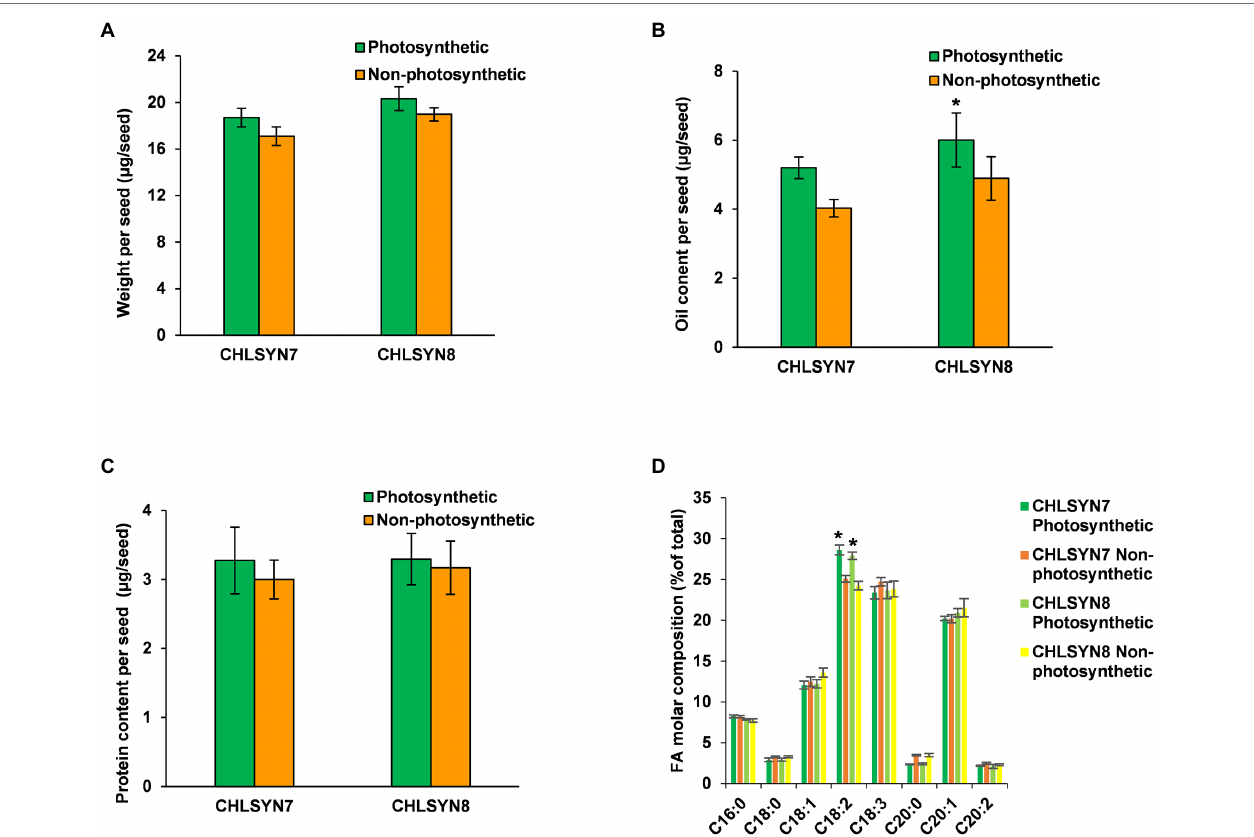
FIGURE 1 | Analyses of seed biomass, oil, and protein contents. (A) Comparison of seed weight in photosynthetic, green seeds (red) and non-photosynthetic, yellow seeds (non-red) from two (CHLSYN7 and CHLSYN8) independent Atchlsyn1-1/CHLSYN lines. (B) FAMEs analysis of seed oil content of red/green (photosynthetic) seeds and, non-red/yellow (non-photosynthetic) seeds from two independent mutant lines CHLSYN7 and CHLSYN8, respectively. (C) Comparison of red/green (photosynthetic) seeds and, non-red/yellow (non-photosynthetic) seeds protein content in two independent complemented lines, CHLSYN7 and CHLSYN8. The two independent lines are represented by orange and green bars, respectively. (D) Fatty acid composition of seed wildtype and mutant seeds. Orange and cyan bar indicates green (photosynthetic) and yellow (non-photosynthetic) seeds of CHLSYN7, yellow and light-green bar indicates green (photosynthetic) and yellow (non-photosynthetic) seeds from CHLSYN8, respectively. Values are means ± SD ( n = 3 biological replicates). Statistical significance was analyzed using the two-sided Student’s t -test. The asterisk indicates a significant difference ( * p <